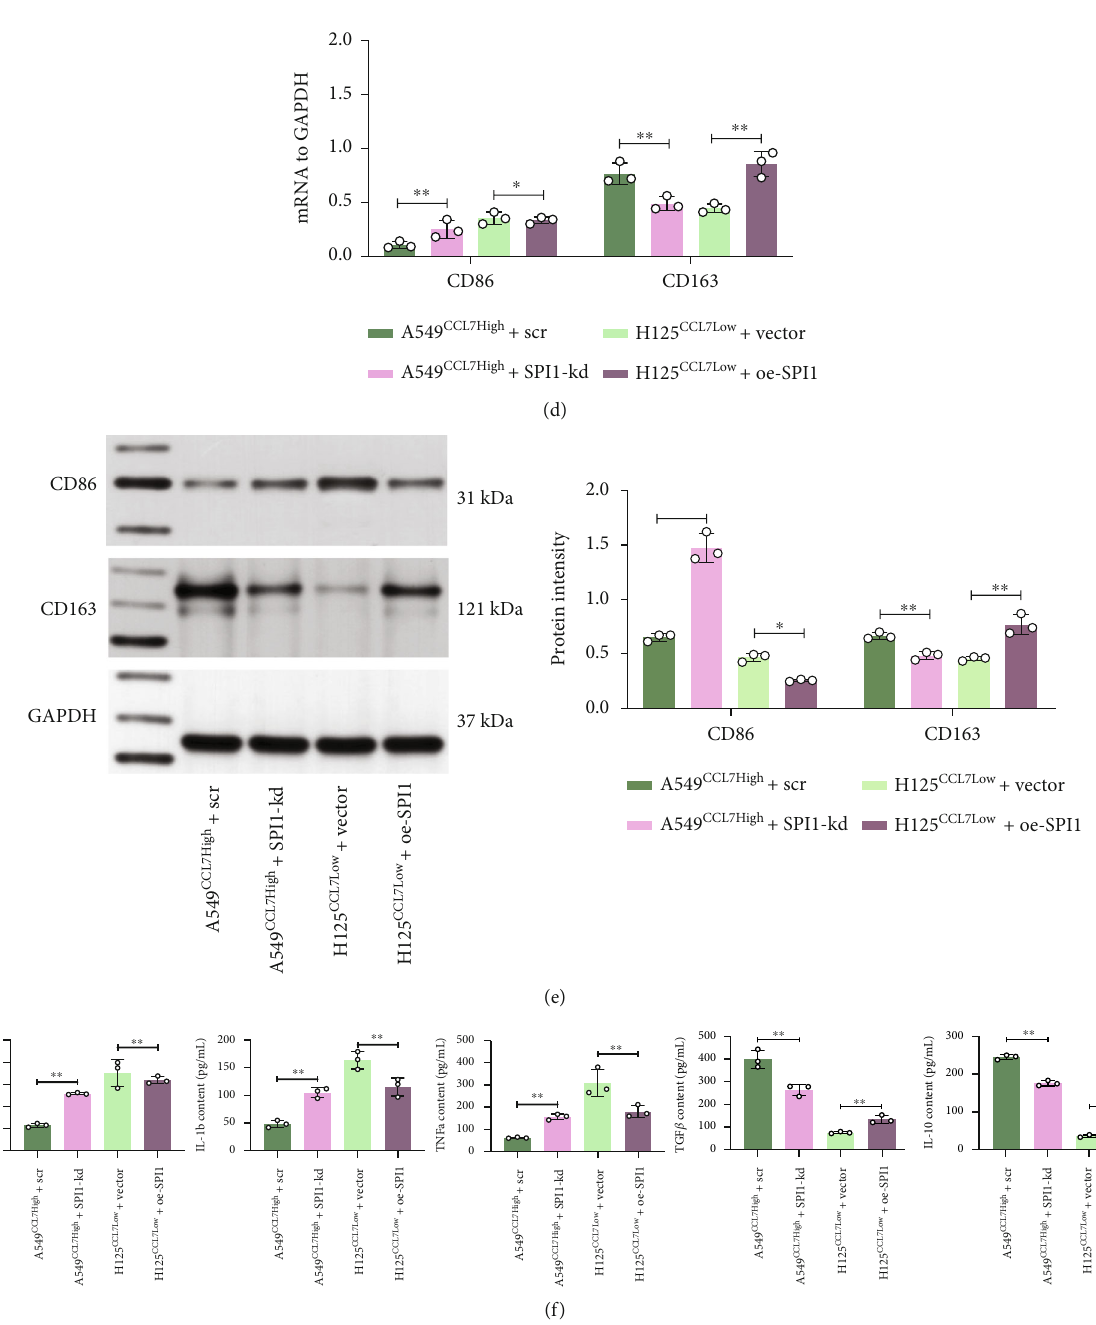
Figure 6: Overexpression of SPI1 in CCL7-low cells promotes macrophage migration and M2 polarization. mRNA (a) and protein (b) levels of SPI1 and CCL7 in H125 CCL7 Low and A549 CCL7 High cells after SPI1 overexpression plasmid or shRNA transfection detected by qPCR and WB analyses; (c) number of migrated THP-1 cells examined by crystal violet staining; mRNA (d) and protein (e) levels of CD86 and CD206 in cocultured THP-1 cells examined by qPCR and WB analyses; (f) expression of M1 cytokines (IL-6, IL-1 β , and TNF- α ) and M2 cytokines (IL-10 and TGF- β ) in the culture medium determined by ELISA kits. Repetition = 3 . Data are presented as the mean ± SD . ∗∗ p < 0 : 01